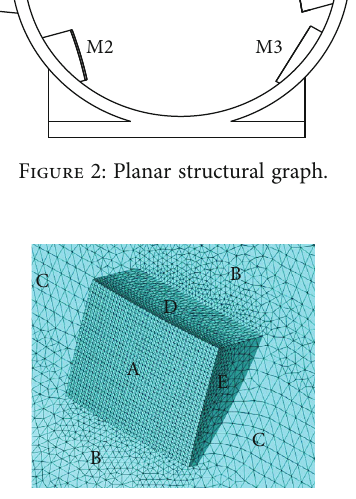
Figure 3: Local fi nite element model.